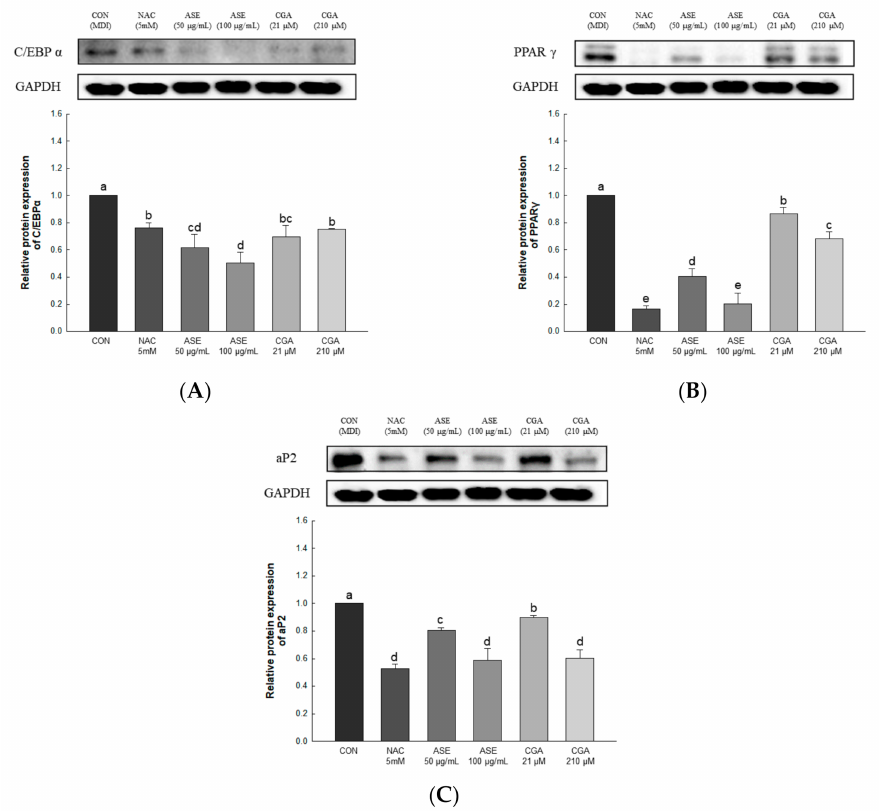
Figure 8. E ff ects of ASE and CGA on the expression level of adipogenic transcription factor in 3T3-L1 adipocyte. Protein expression of C / EBP α ( A ), PPAR γ ( B ), and aP2 ( C ). 3T3-L1 adipocytes di ff erentiated for 6 days were treated with ASE (50 and 100 µ g / mL) and CGA (21 and 210 µ M). Protein expression was quantified through western blotting and normalized through GAPDH expression level. Each value is expressed as the mean ± SD of triple determination. The other letters on the bars indicate a significant di ff erence of p < 0.05 in the Duncan multi-range test. a, b, c, d, e, bc and cd significant di ff erences among various parts of